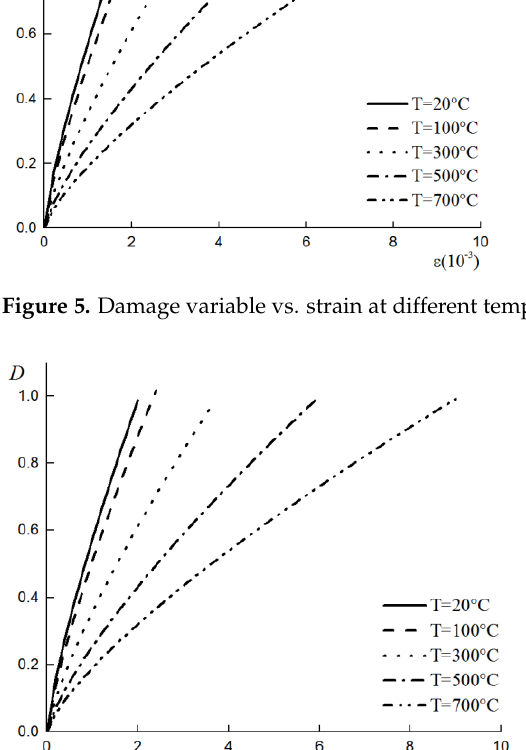
Figure 6. Damage variable vs. strain at different temperatures (C40 concrete).